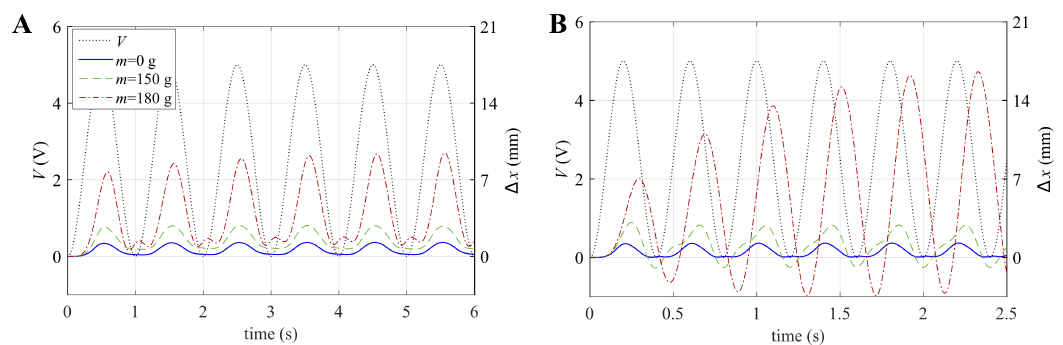
Figure 9. Time series of the applied voltage and measured displacement with different values of the constant applied force (hung mass) for excitation frequencies of ( A ) 1 Hz and ( B ) 2.5 Hz.